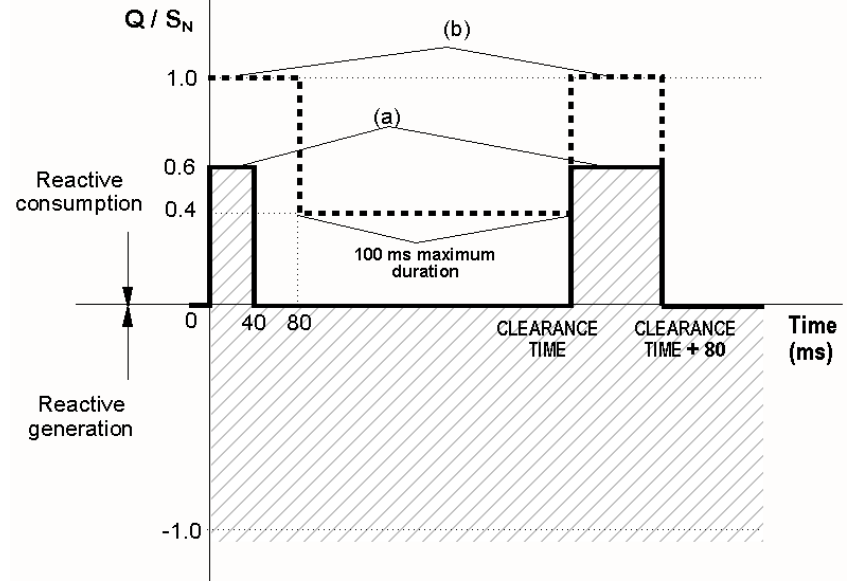
Figure 2. Reactive power limitations established by Spanish grid code: ( a ) three-phase faults; ( b ) single- and two-phase